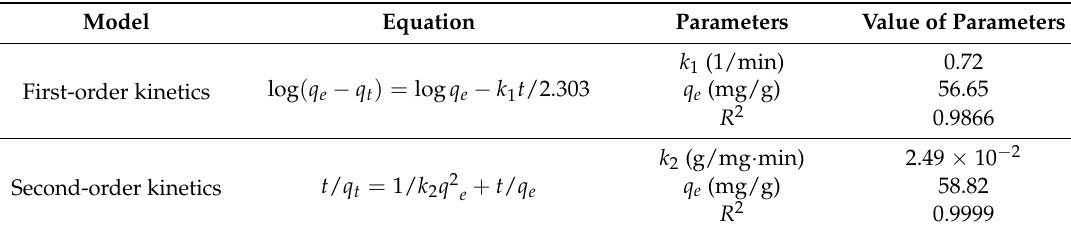
Figure 14. Time dependent study of Rh B removal by nZVI/rGO. (initial pH = 5.0; nZVI/rGO dosage = 40 mg; temperature = 25 ◦ C; Rh B concentration = 60 mg/L). Table 6. Kinetic parameters for the removal of Rh B on nZVI/rGO.